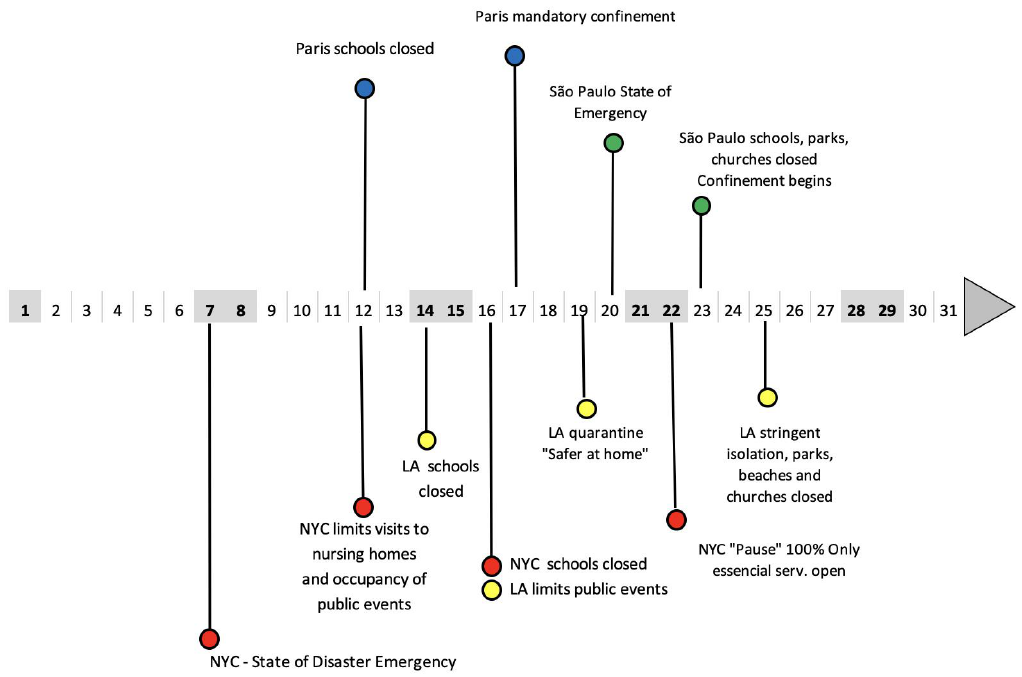
Figure 1. Timeline of the confinement measures taken in Sao Paulo, New York, Paris, and Los Angeles during March 2020 to prevent infection by the novel coronavirus.